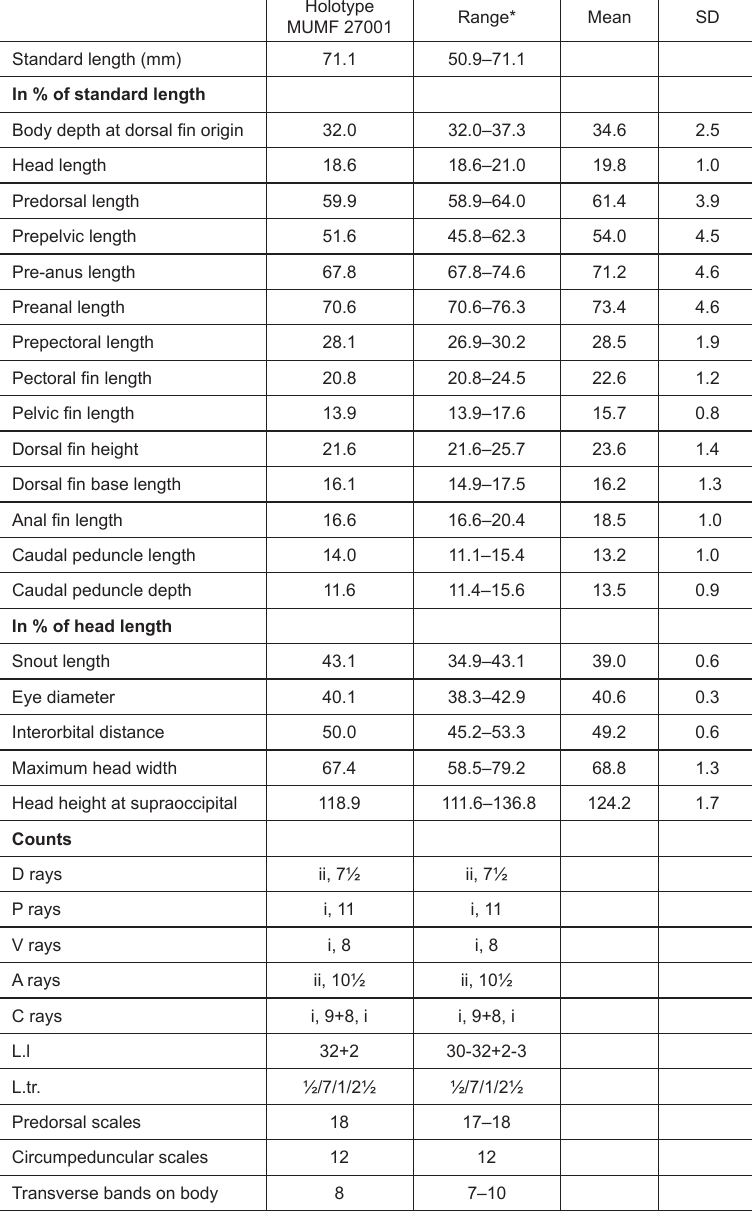
Table 1. Morphometric data for Barilius profundus sp. nov.